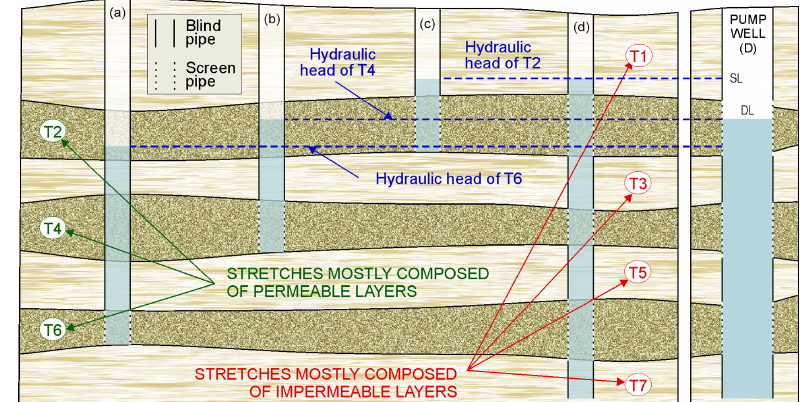
Figure 3. Hypothetical example of the results that would be obtained in a large detrital basin composed of seven different stretches so that permeable stretches T2, T4, and T6 would be hydraulically separated from each other by impermeable stretches T1, T3, T5, and T7; stretches T2, T4, and T6 would have different hydraulic heads, which are drawn in hypothetical wells A, B, C, and D, with different depths and different filtering intervals. Considering the plotted depth and filter intervals of well D, if pumped with the plotted dynamic level DL (coincident with the hydraulic head of T4; see the right part of the figure), only the T2 stretch contributes water to the well, T4 does not, and T6 collects water from the well. Note that the well diameters plotted are not scaled but are highly magnified to enhance the view of the